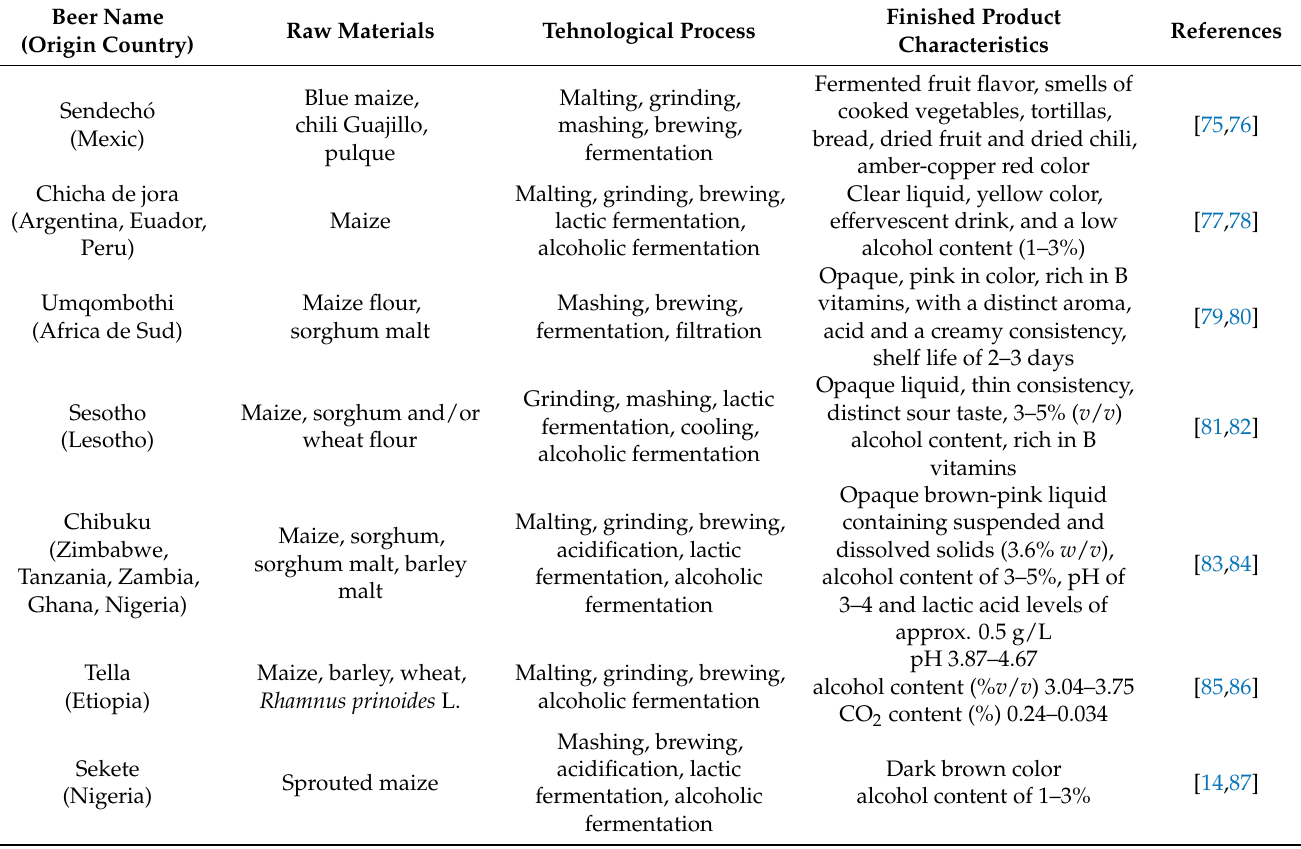
Table 2. Beer assortments in which maize is used as a raw